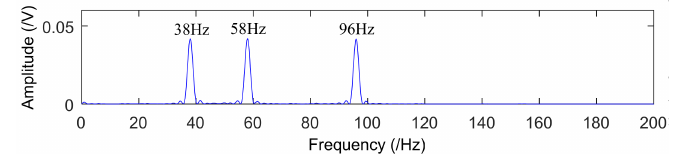
Figure 11. Diagonal slice spectrum of original